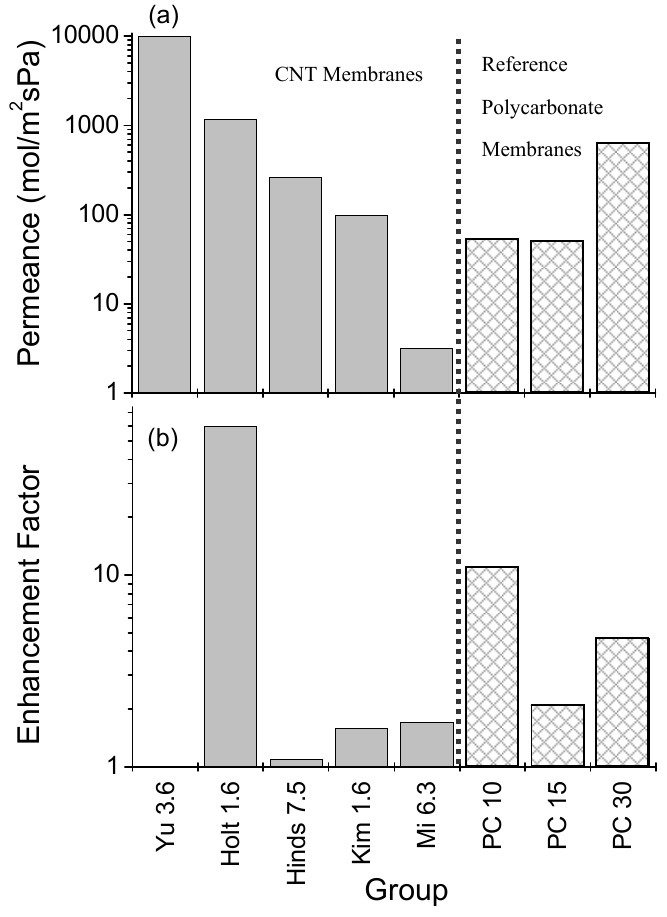
Figure 16. Summary of gas permeance values reported in the literature for isoporous CNT membranes: (a) Permeance and (b) Enhancement Factor which is defined as the measured permeance divided by the permeance predicted assuming Knudsen flow. An enhancement value is not given for Yu et al . as gas flow is through both the CNT hollow interior and gaps between CNTs. The last three cross-hatched bars are for polycarbonate track etched membranes. PC10 and PC30 were measured by the authors, while PC15 is taken from [1]. The pore diameter (in nm) is given after the name of each